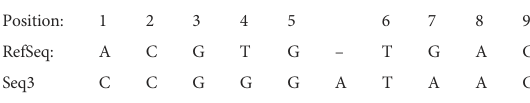
Whether the SNP of each HIV-1 genome changes over time is counted. The 11897 genomes are aligned with the reference sequence of HIV-1 fi rst, and the non-unique single mutations of each genome is counted, as illustrated in Figure 2. The x-axis represents the year, y-axis represents total SNP count, and each dot represents a sequence. As time went on, the total number of mutations did not change signi fi cantly. The mutations in most genomes ranged from 500 to 1500, but 21 genomes have abnormal mutation numbers, which are distributed in 20 years (from 1991 to 2011, marked with No. 1 to No. 13). Of the 21 sequences, 9 are from Cameroon, 7 from France, 2 from Gabon, 1 from Senegal, 1 from Spain, and 1 from the United States. About half of these highly mutated sequences are located in African countries, but they are all distributed in Atlantic coastal countries (Supplementary Figure 1).